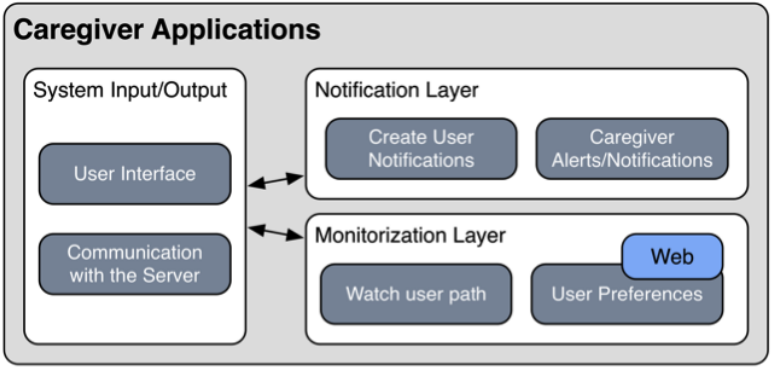
Figure 4. Localization system for caregivers. ( a ) Android application; ( b ) Web application.